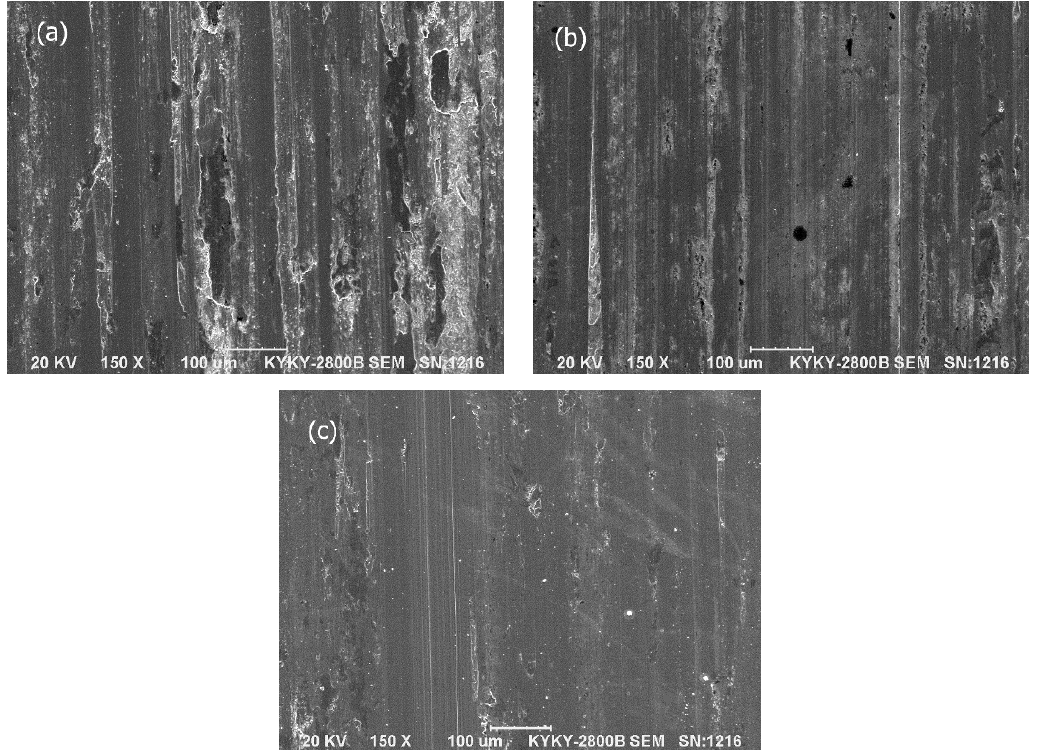
Figure 9. Worn surface morphologies of the hardened 1.0%C–1.5%Cr bearing steel wear counterpart wheel coupled with the hardened 0.45%C steel ( a ); austenitic 1Cr18Ni9Ti stainless steel ( b ); and the Mo–40Ni–13Si alloy ( c ), at a contact load of 196 N for a sliding distance of 3312 m.